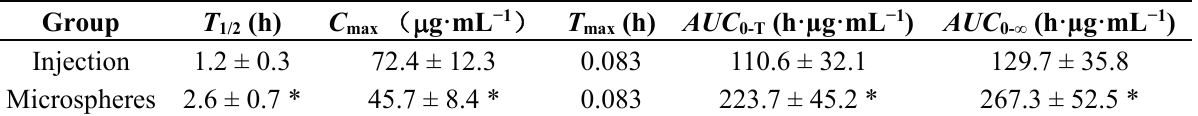
Table 1. Pharmacokinetic parameters of lidocaine in rats after intravenous administration of two formulations ( n =